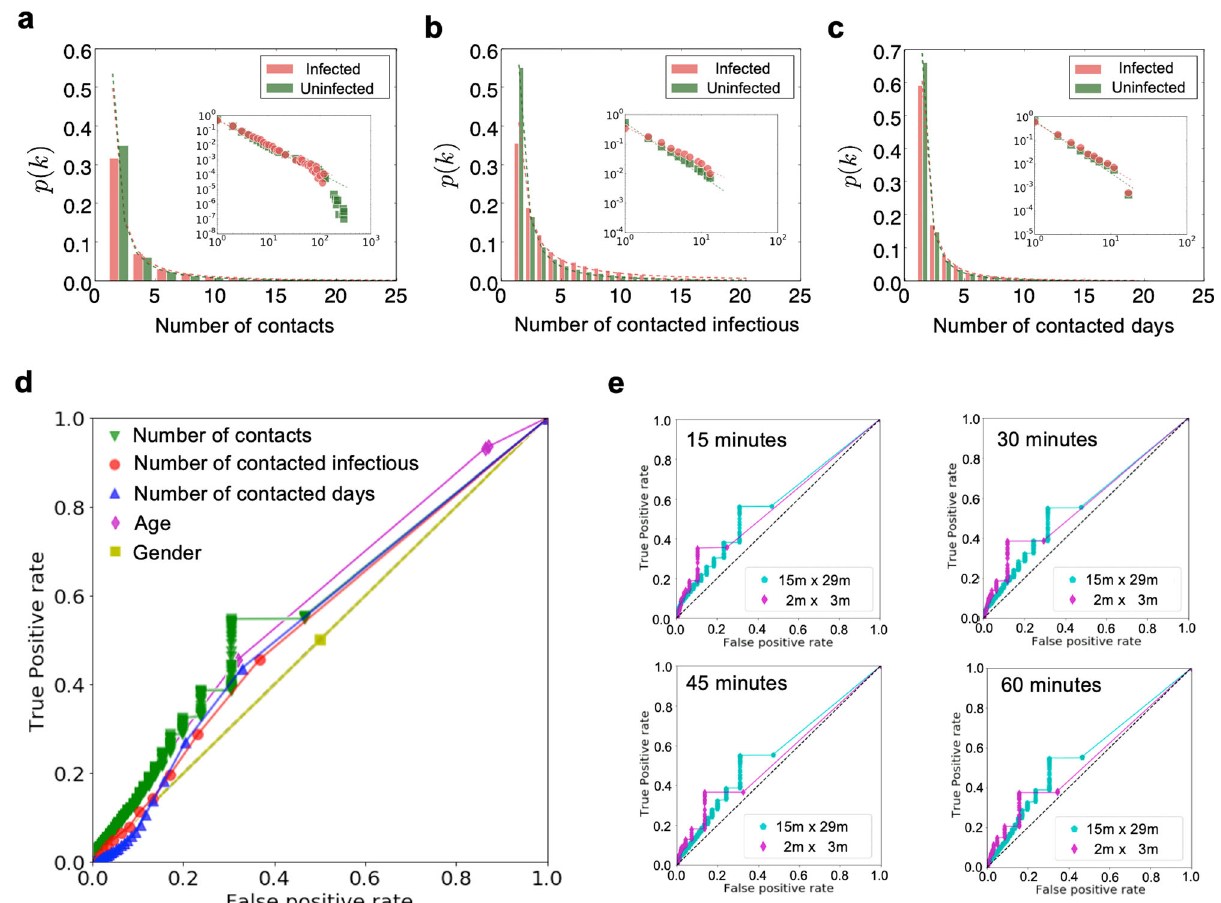
Fig. 5 Infection risk evaluation based on the Bayesian framework. a The distributions of the numbers of contacts with the infectious by infected and uninfected contacted individuals, respectively. b The distributions of the numbers of the infectious by infected and uninfected contacted individuals, respectively. c The distributions of the days of contacts with the infectious by infected and uninfected contacted individuals, respectively. d The ROC curves for the risk evaluation. Here the x -axis denotes the false positive rate and the y -axis denotes the true positive rate, where a random guess gives a point along the dashed diagonal line. e The ROC (receiver operating characteristic) curves for the risk evaluation with different temporal and spatial